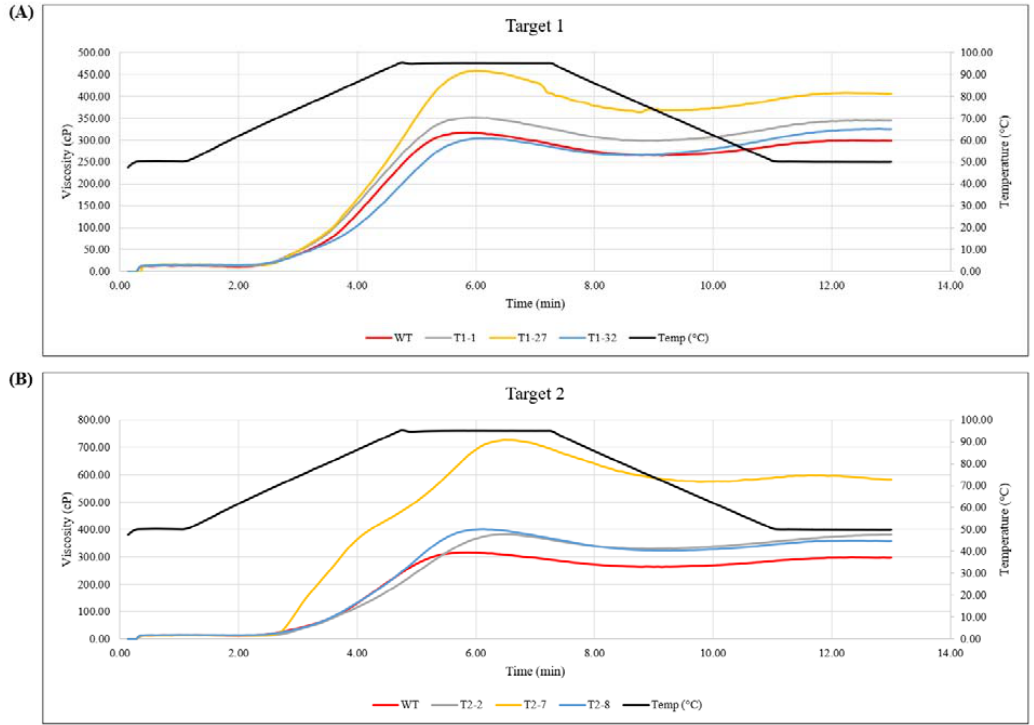
Figure 6. Viscosity and temperature profiles as determined by Rapid Visco Analyzer (RVA). ( A ) RVA profiles for control (unedited, wild ‐ type (WT)) and edited events for Target 1. ( B ) RVA profiles for control (unedited, wild ‐ type (WT)) and edited events for Target 2.